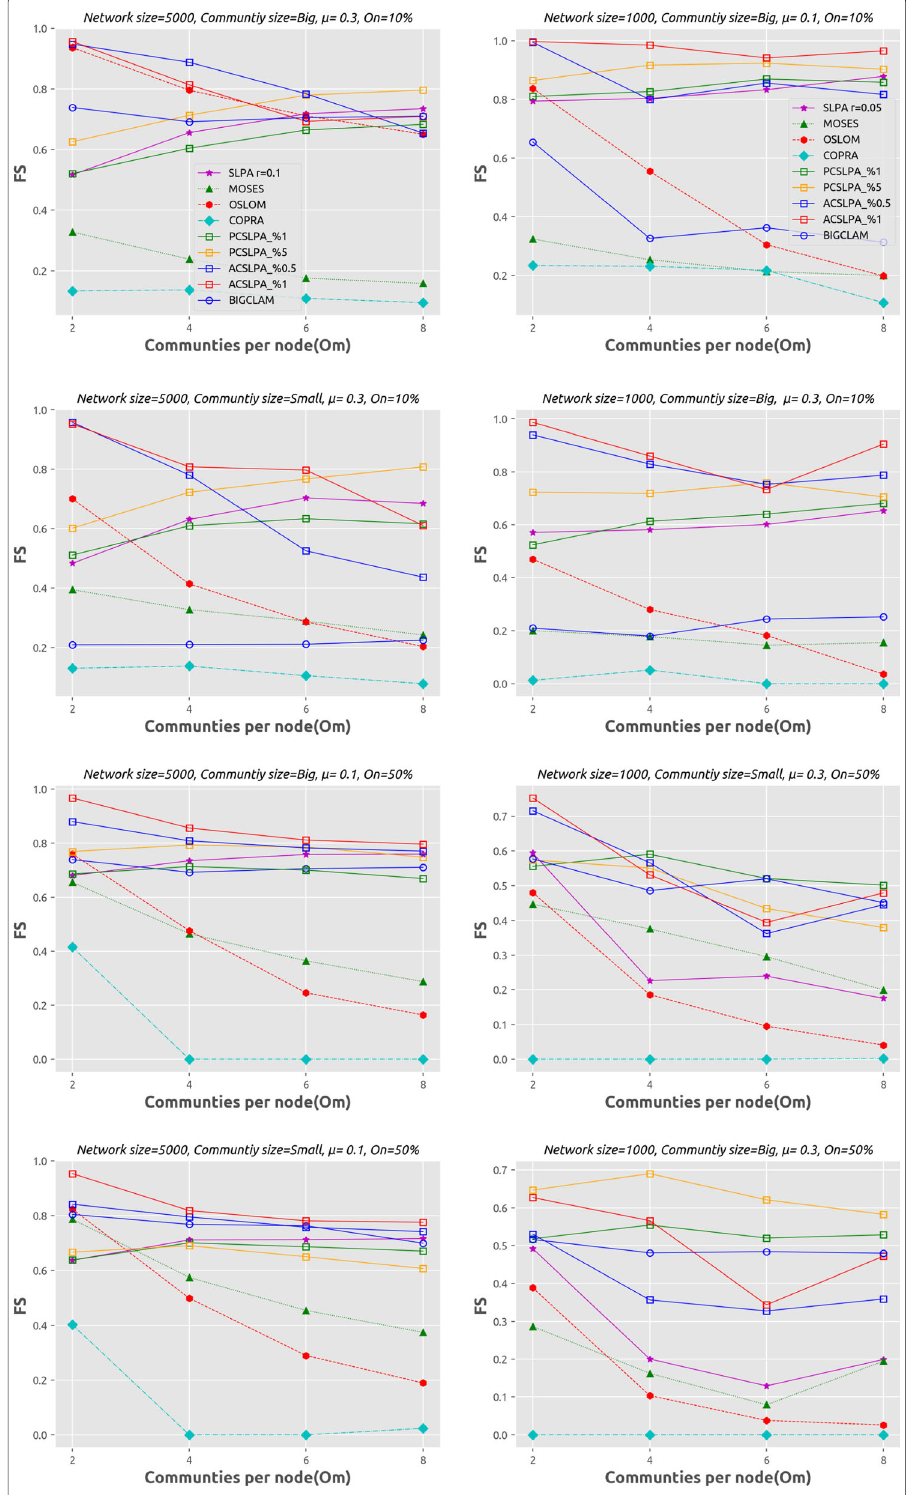
Fig. 6 Summary of the performance of all algorithms on synthetic networks, containing both small and large communities, where the mixing parameter μ varies from 0.1 to 0.3. F-measure values are plotted against the number of communities per node ( O m ) , with 4 networks in each